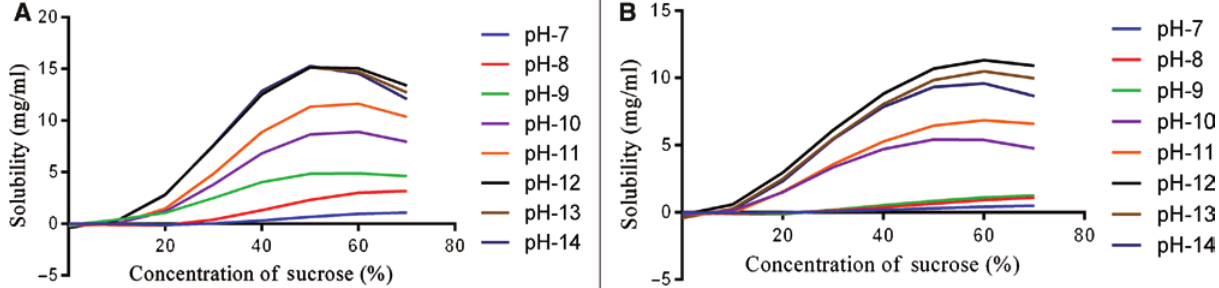
Figure 3: (A) Effect of concentration of sucrose on solubility of β , β -dimethylacryl shikonin (BDMS) at different pH. (B) Ursolic acid